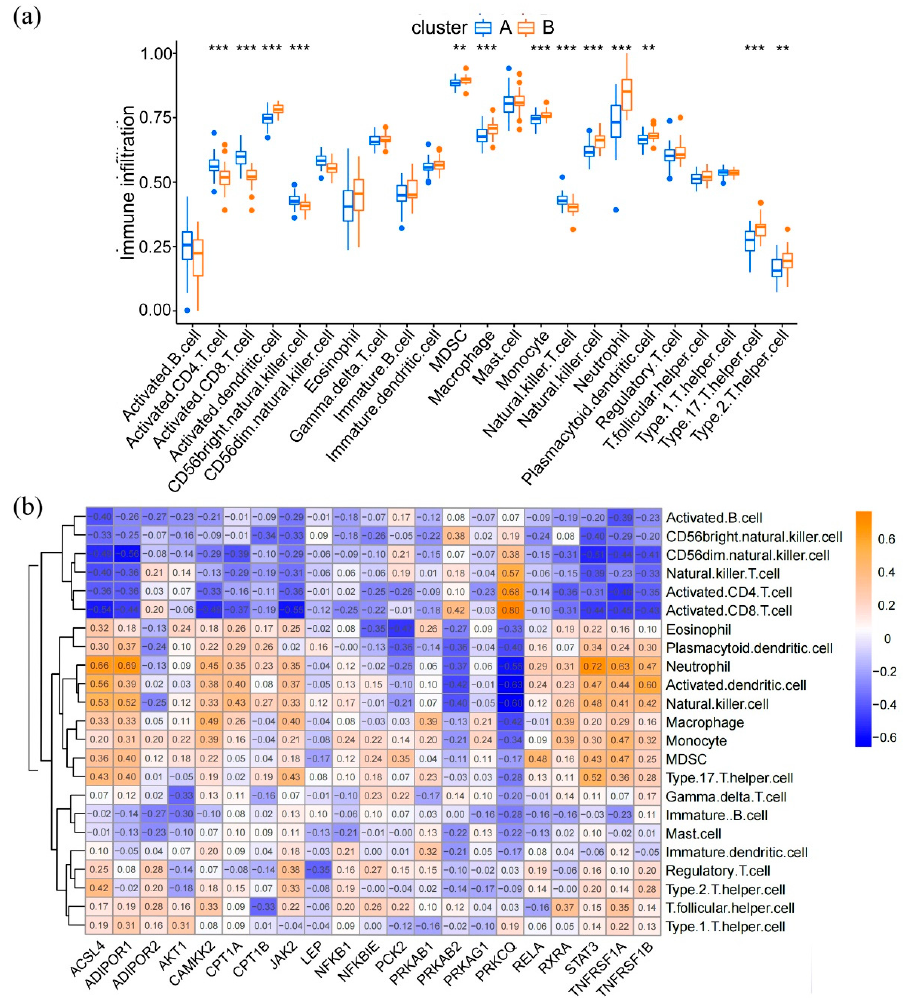
Figure 7. Characteristics of immune cell infiltration in different gene expression patterns and the correlation of immune cells with individual genes. ( a ) Abundance of 23 infiltrating immune cells in different clusters. ( b ) The correlation between the infiltrating immune cells and the adipocytokine pathway-related genes. ** p < 0.01, *** p < 0.001.